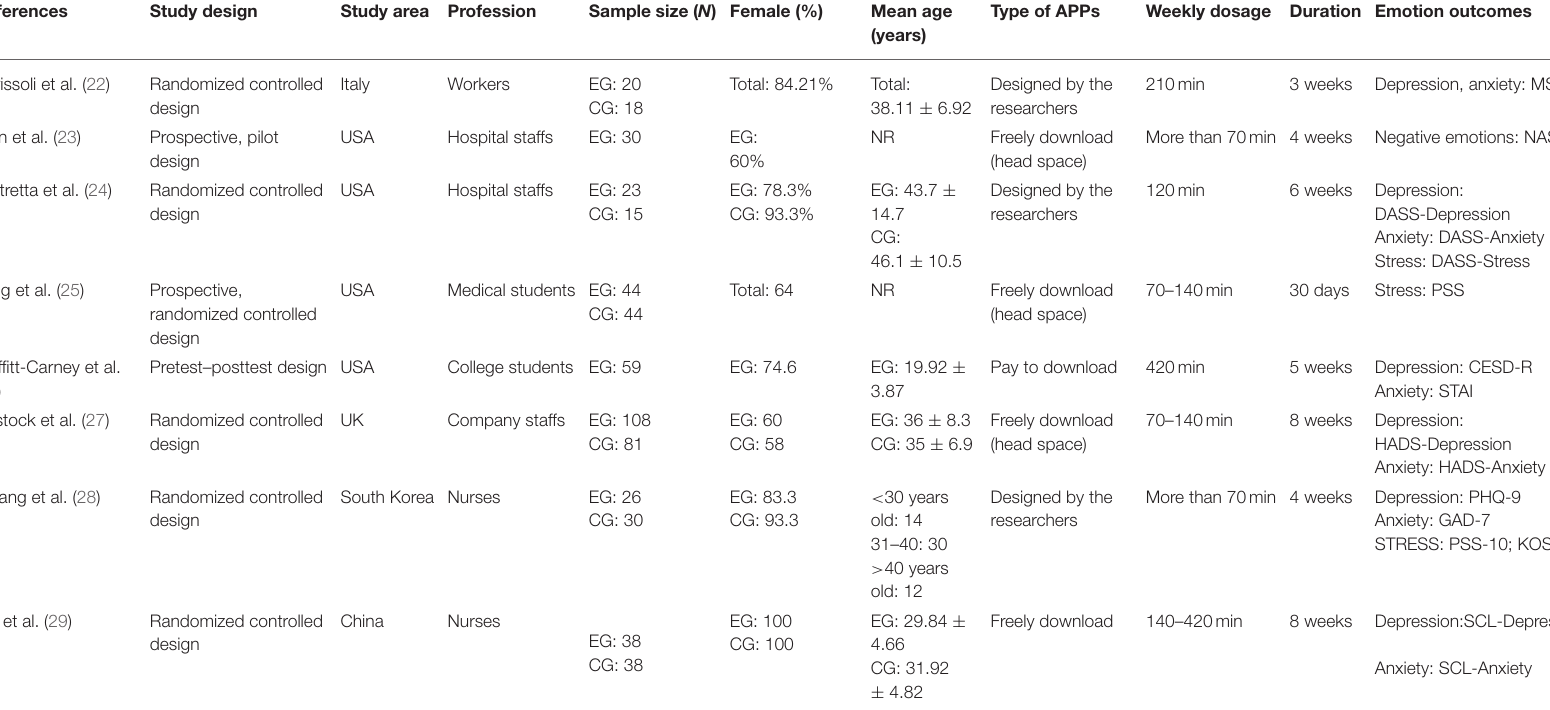
TABLE 1 | Characteristics of eligible